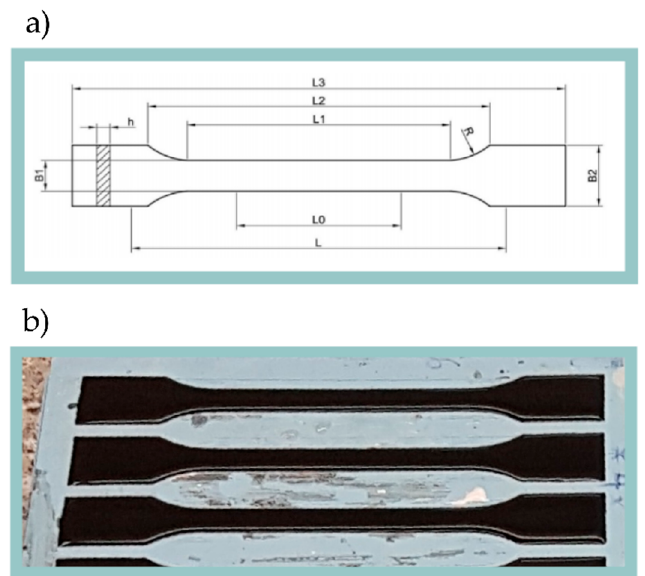
Figure 1. ( a ) Geometry of the sample for tensile test where: L3—Total length: 150 mm; L1—Length of parallel edges narrow zone: 60 mm; R—Radius: 60 mm; B2—Width at ends: 20 mm; B1—Width at narrow zone: 10 mm; h—Thickness: 4 mm; L0—Reference length: 50 mm; L—Length between clamps: 115 mm. ( b ) Nanocomposite casted to the silicone forms.